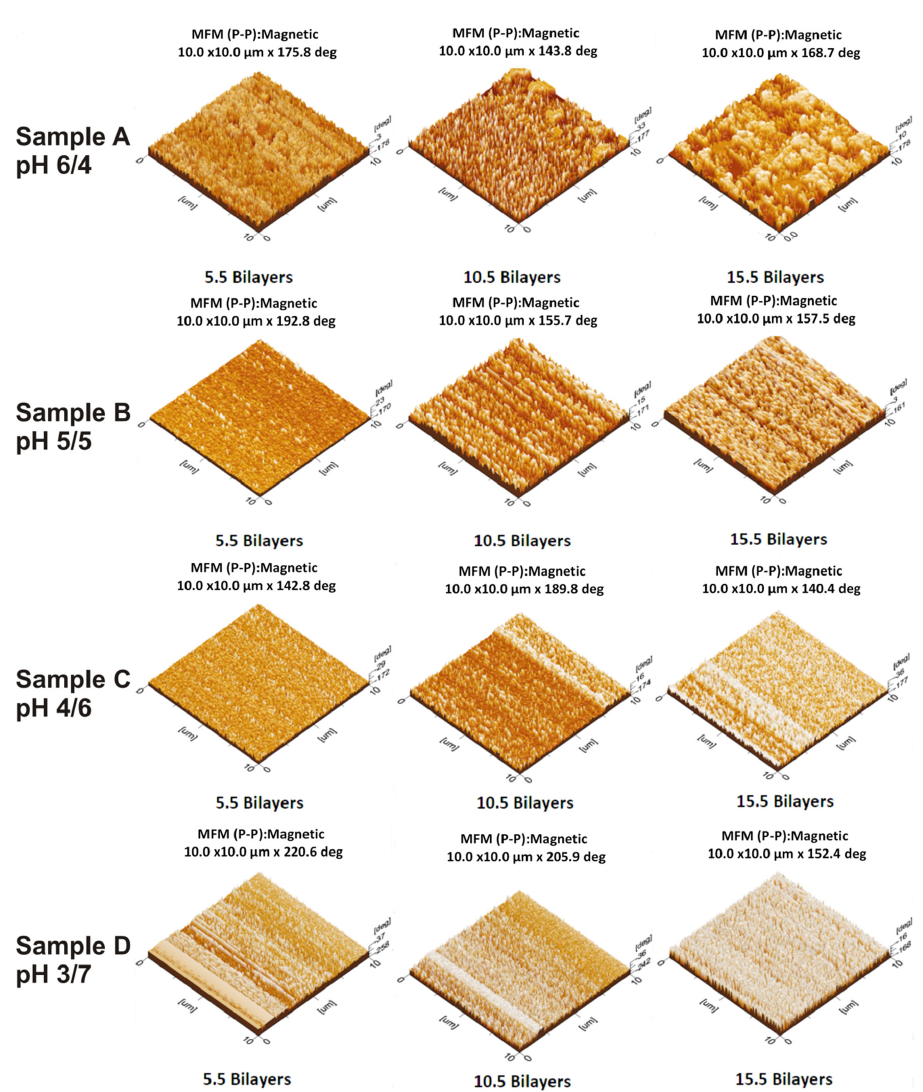
Figure 13. Magnetic force microscopy (MFM) images of thin film gradients of samples A, B, C and D fabricated at various pH combinations.